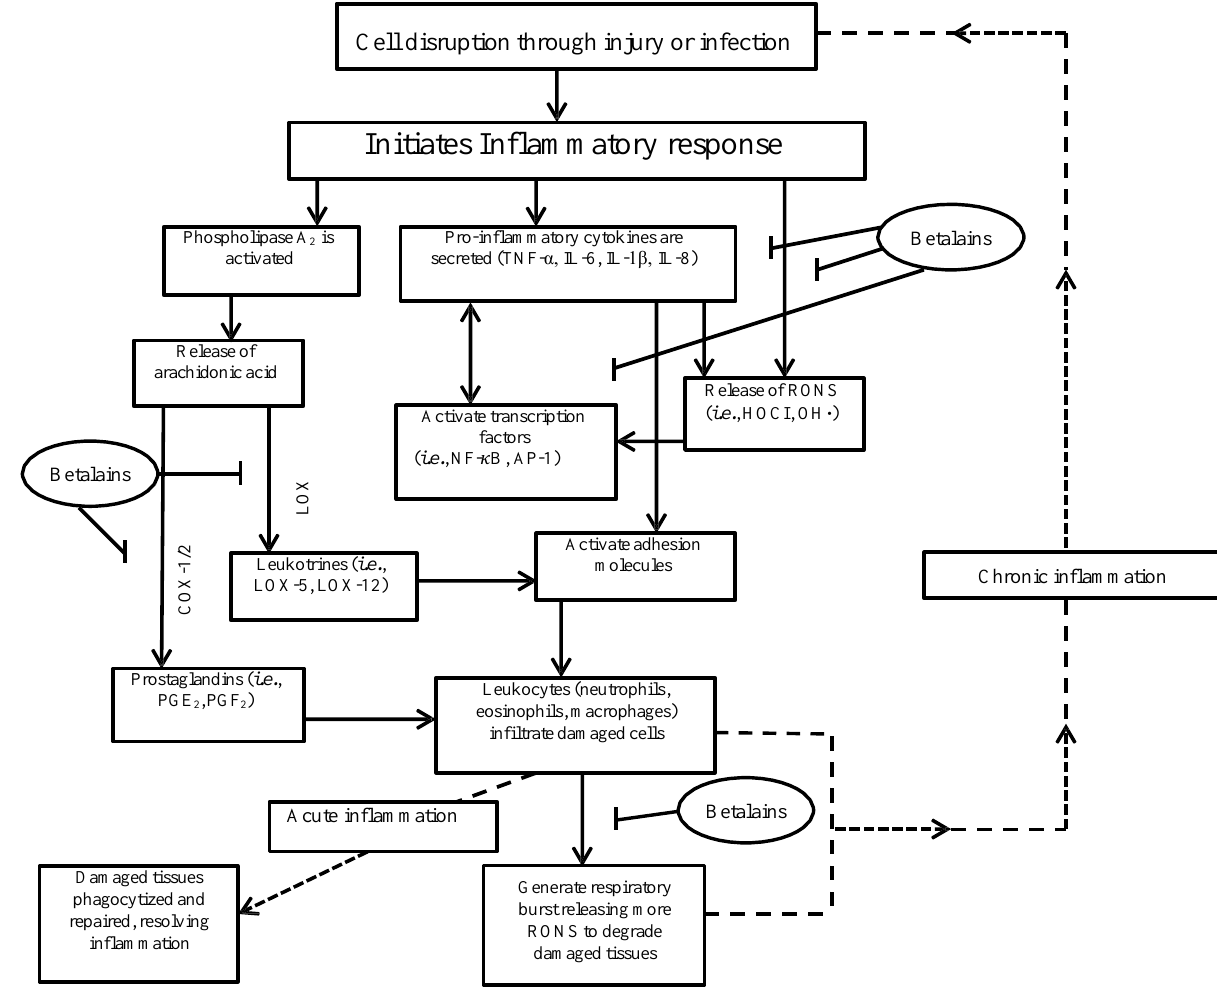
Figure 4. Illustration of the inflammatory cascade in response to cellular attack and possible pathways where betalains may exhibit inhibitory effects. PGF2, Prostaglandin F2; PGE2, Prostaglandin E2; COX ½, Cyclooxygenase 1 and 2; LOX, lipoxygenase; LOX-5, 5-lipoxygenase; LOX-12, 12- lipoxygenase; HOCI, Hypochlorous acid; OH•, Hydroxyl radical; NF-κB, Nuclear Factor-Kappa B; AP-1, Activator protein 1; IL-6, Interleukin-6; IL-8, Interleukin-8; IL-1β, Interleukin-1 beta; TNF-α, tumour necrosis